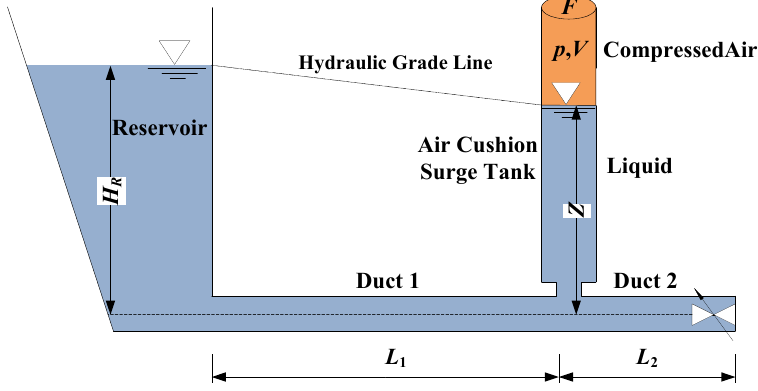
Figure 19. Reservoir-air cushion surge tank-valve